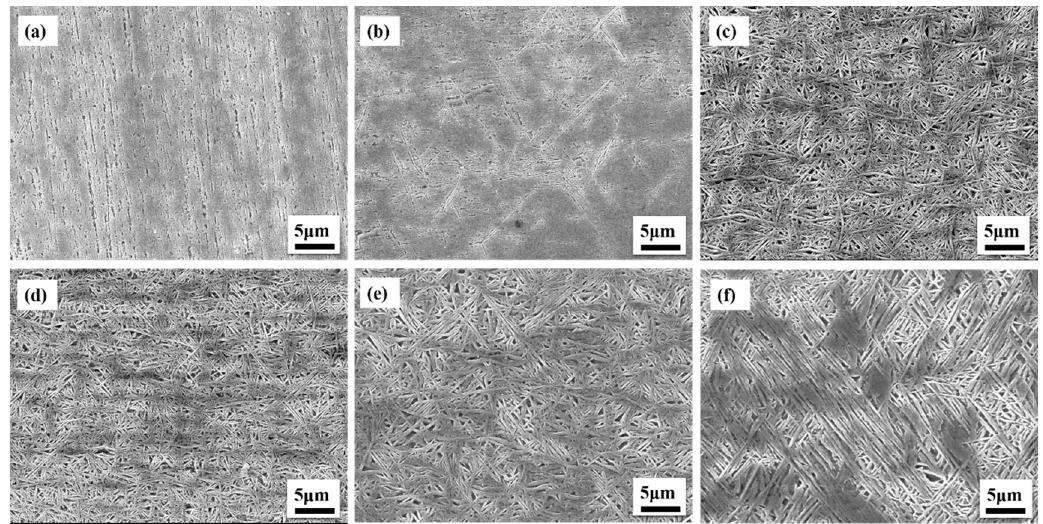
Figure 3. SEM photos of different regions along the length of the #1 sample: ( a ) 160 °C, 10 mm from the top; ( b ) 240 °C, 47 mm from the top; ( c ) 270 °C, 53 mm from the top; ( d ) 300 °C, 64 mm from the top; ( e ) 370 °C, 67 mm from the top; and ( f ) 440 °C, 69 mm from the top.